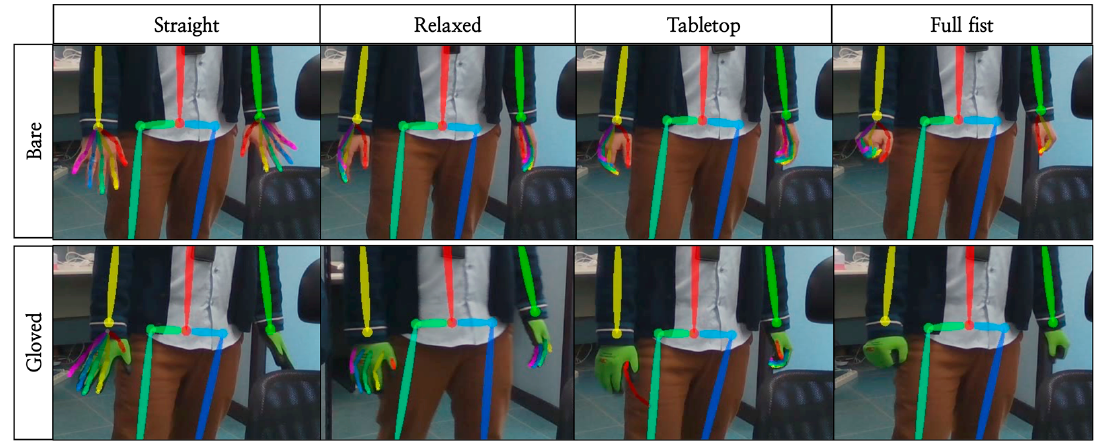
Figure 4. Comparison of OpenPose estimation results based on hand posture for bare and gloved hands.